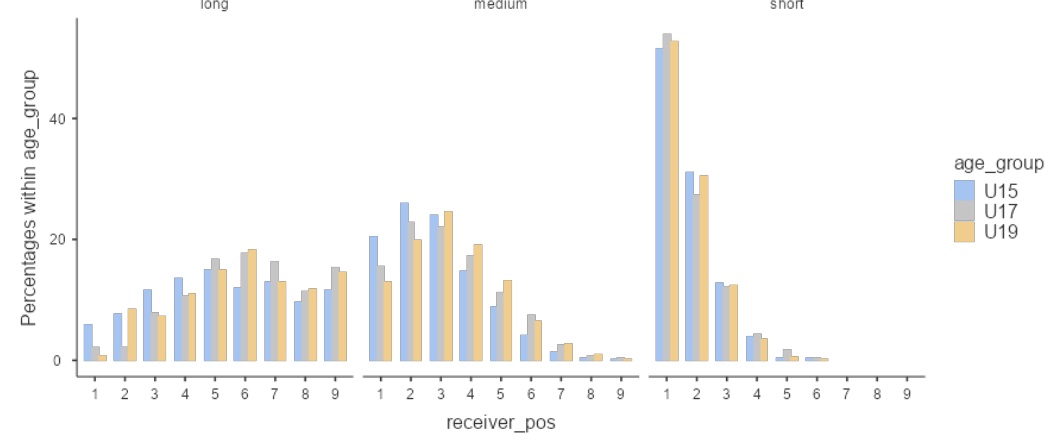
Figure 3. Passing distribution relative frequency of completed passes considering the relative distance between the ball receiver and the ball carrier, per age group and pass length.